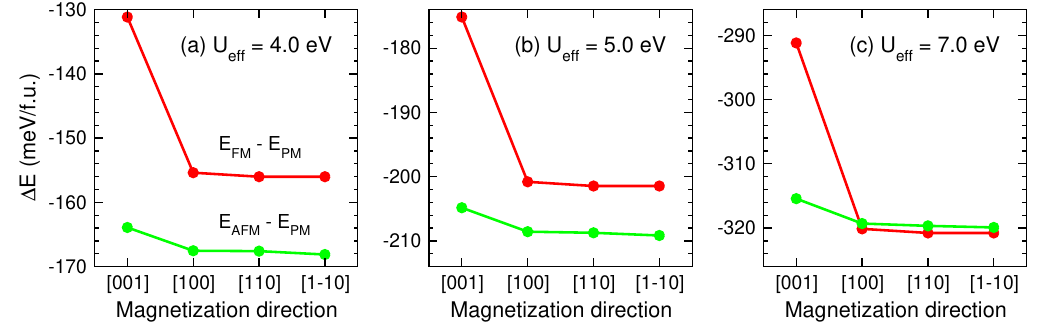
= 7 eV. ef f ( z ) = − 0.032, t ( z ) 11